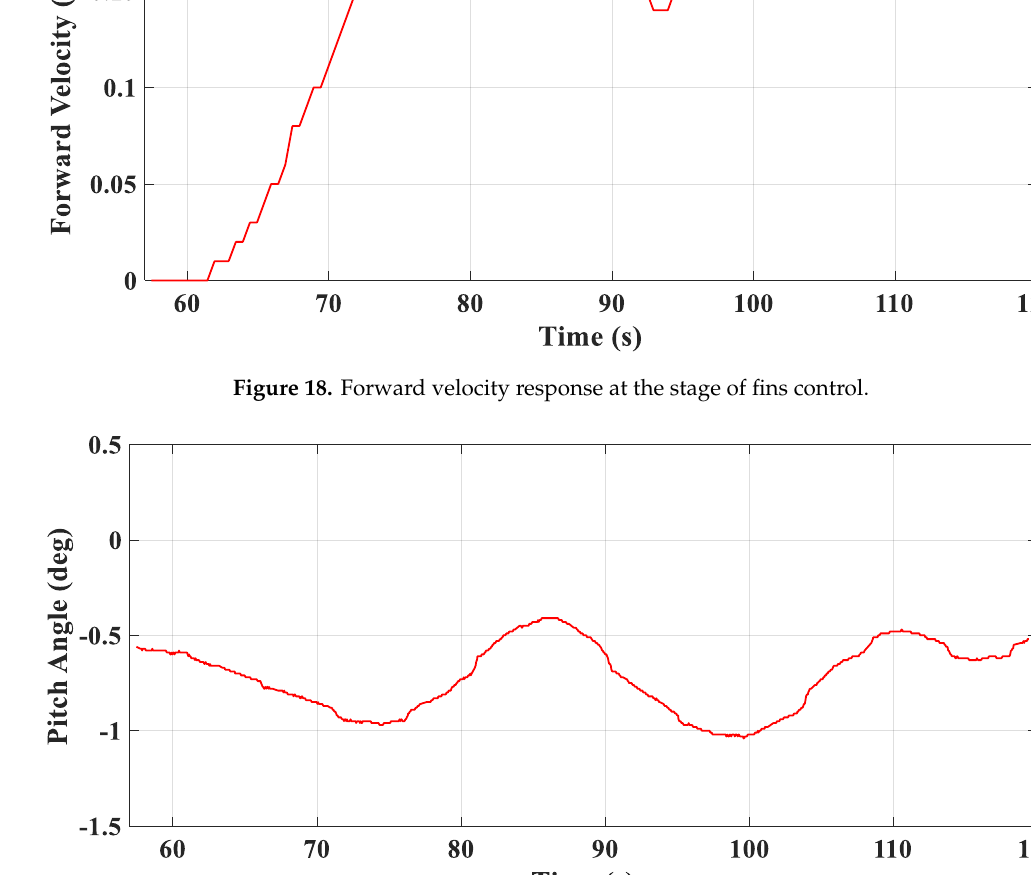
Figure 20. Depth response under combined control strategy. The normalized VBS and fin commands are given in Figure 15 chronologically. Figures 16 and 17 reveal the good mass tracking performance of the on-off type VBS again, despite the inherent small tracking error. The forward velocity response is depicted in Figure 18, which shows that the vehicle reaches the velocity of 0.05 m/s, at which the fins come into play, at about 𝑡 = 65 s . The pitch angle response seen in Figure 19 shows the good passive pitch stability of the vehicle. The satisfactory depth control performance of the combined control strategy is verified in Figure 20. It shows that the VBS stops and the fins start working at 𝑡 = 57.3 s and the vehicle continues descending, due to inertia, to the maximum depth of 1.27 m at about 𝑡 = 65 s . It is at this moment that the fins take effect, and the depth is restored and well maintained with almost no steady-state error. 5.3. Hovering Control Performance under Model Uncertainty and Unknown Disturbances The above work assumes that AUVs operate under nominal conditions, i.e., without modeling errors and external disturbances. As the precise estimation of the hydrodynamic coefficients is difficult, and unknown disturbance cannot be neglected when working under rough sea conditions, the behaviors of the proposed hovering control system with respect to such nuisances are further studied via simulations. The vehicle is assumed to have a net buoyancy of 1.35 kg when the ballast tank is empty and initially hovers at a certain depth, and is commanded to respond to a depth change demand of 1 m.